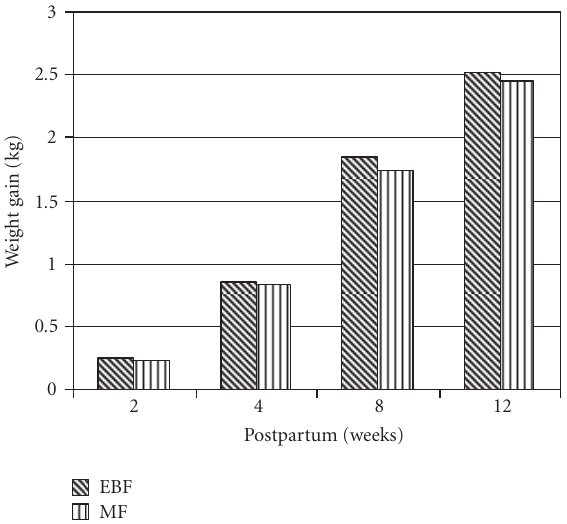
Figure 1: Changes in infant body weight with respect to birth weight ( EBF: exclusive breastfeeding; MF: mixed feeding).